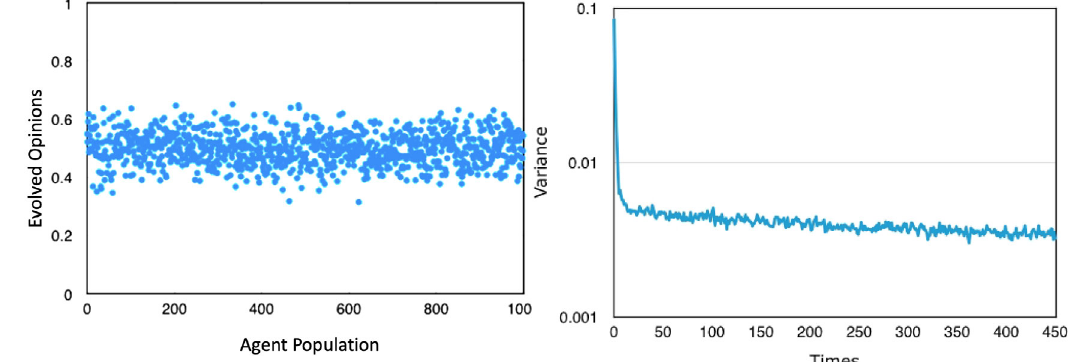
Fig. 2 Opinion dynamics in the population with Gaussian stubbornness